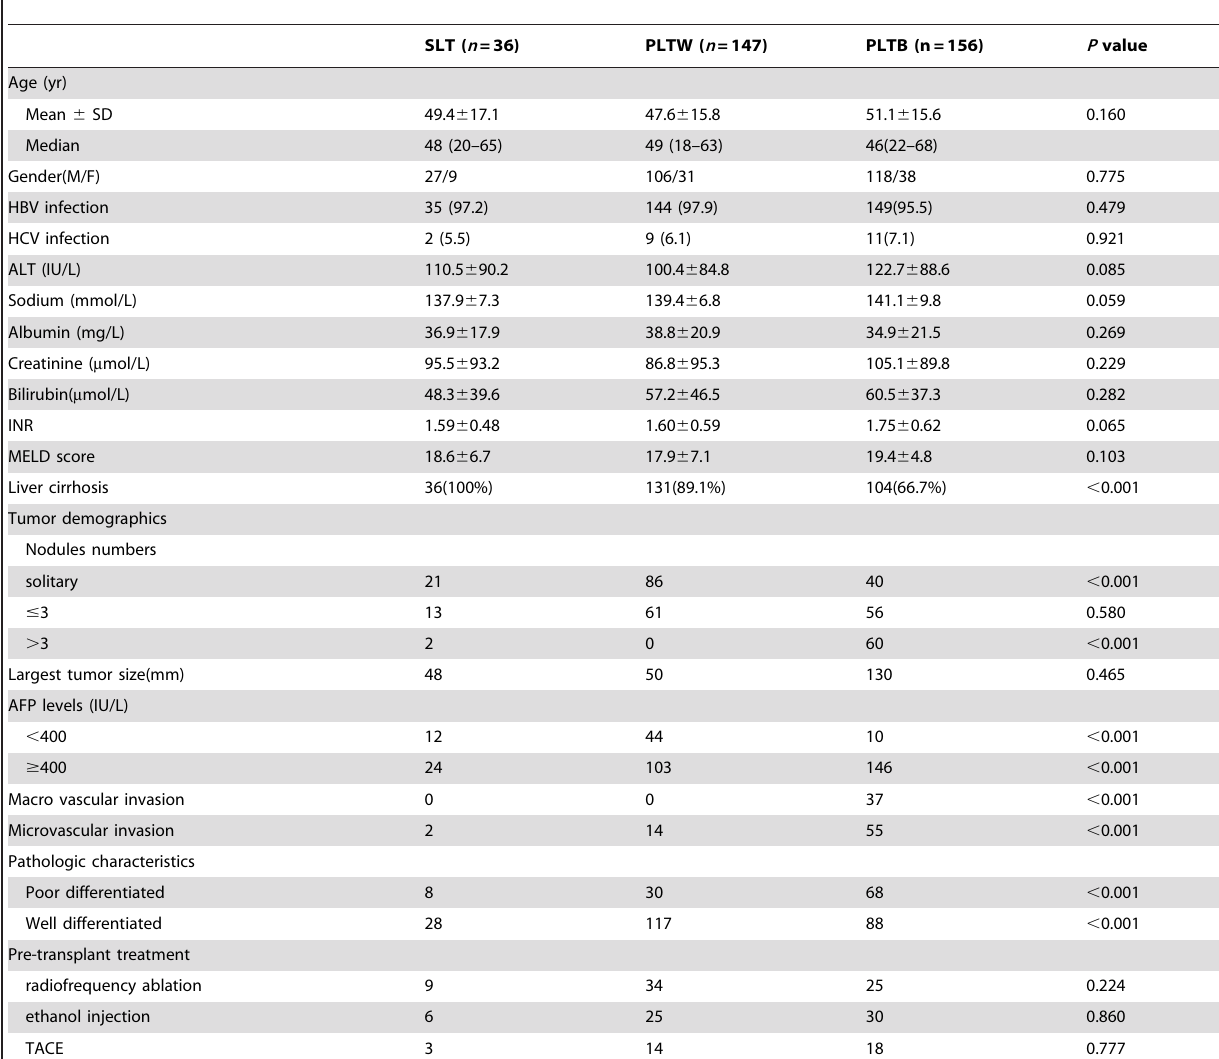
Table 1. Demographics of the patients.